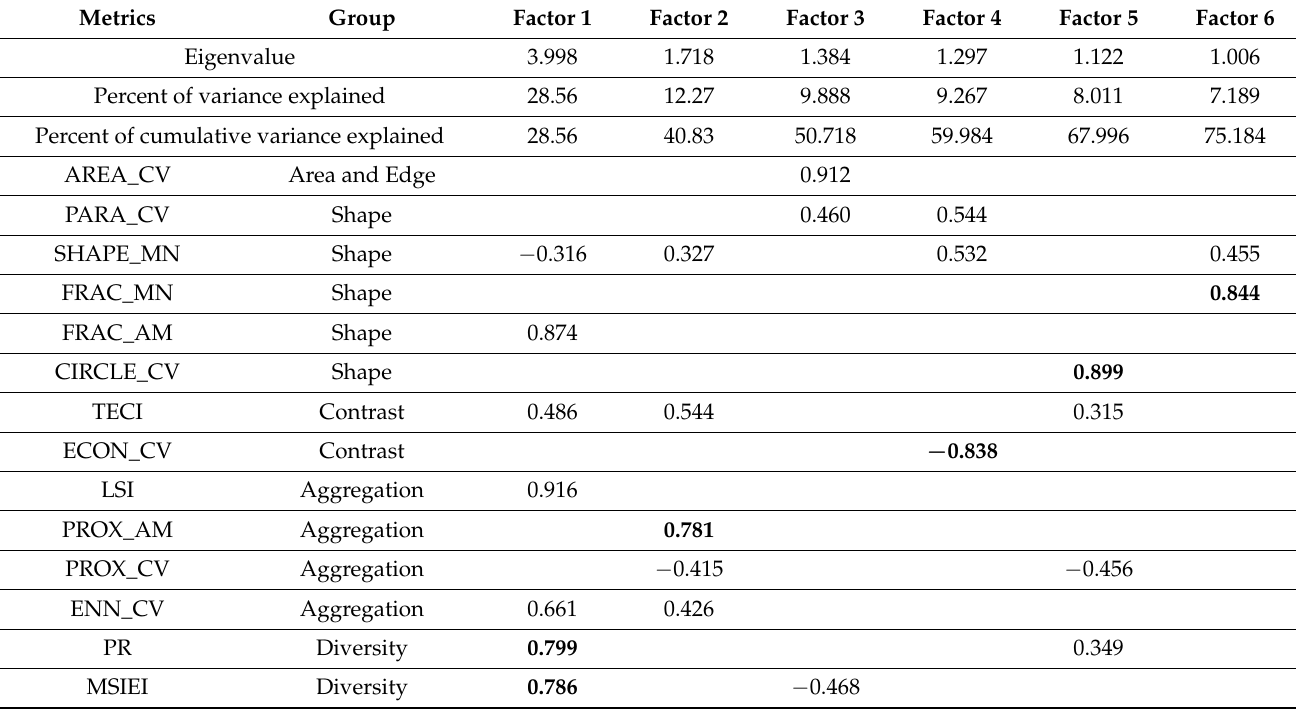
Table 3. Overall factor analysis for the 500 ha hexagon grid including 14 metrics retained after Spearman correlation